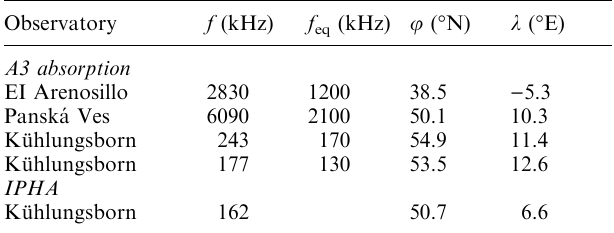
Table 2. Parameters of the A3 absorption and IPHA circuits used – name or location of the observatory, frequency, equivalent vertical frequency, geographic latitude ( (cid:117) ) and longitude ( (cid:107) ) of reflection point Observatory